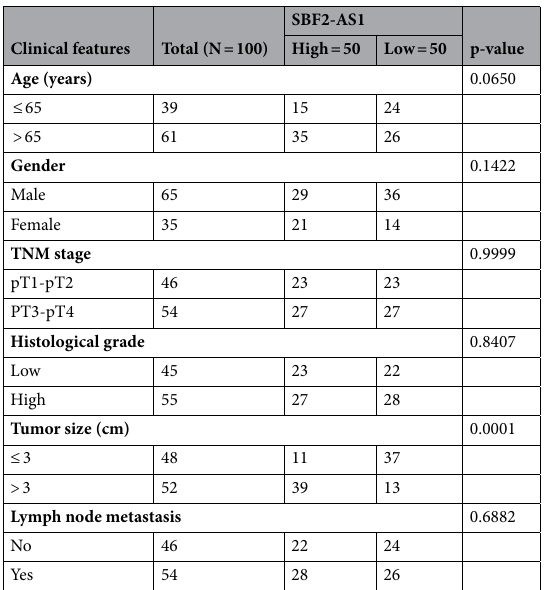
Table 1. The correlation between clinicopathological parameters and SBF2-AS1 expression in human esophageal cancer. Pearson chi-square test was used for comparison between subgroups. Bold values indicate p-value < 0.05.